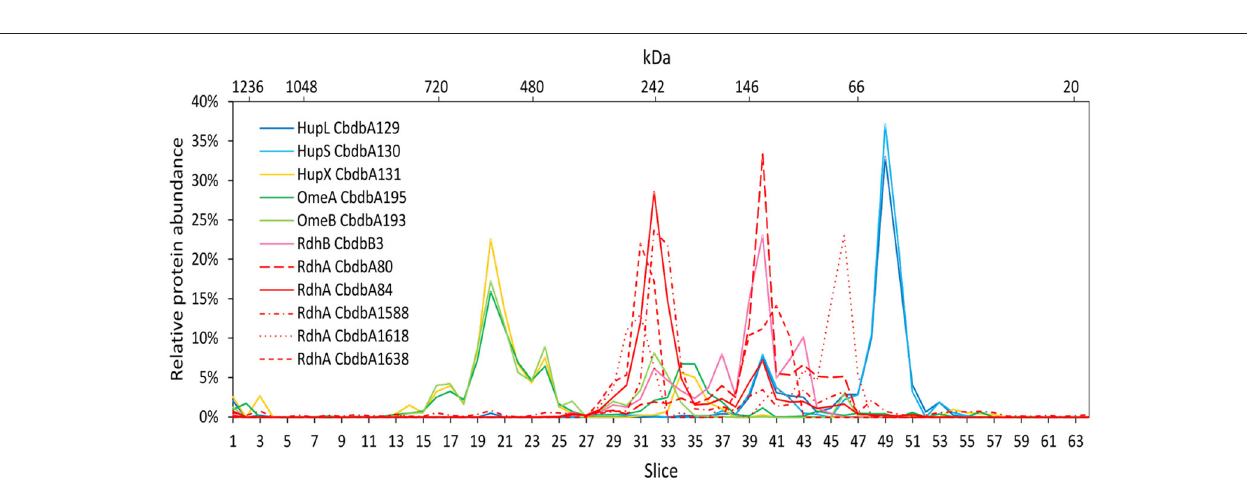
( Supplemental Figure 1C ), and RdhA CbdbA1588 (data not